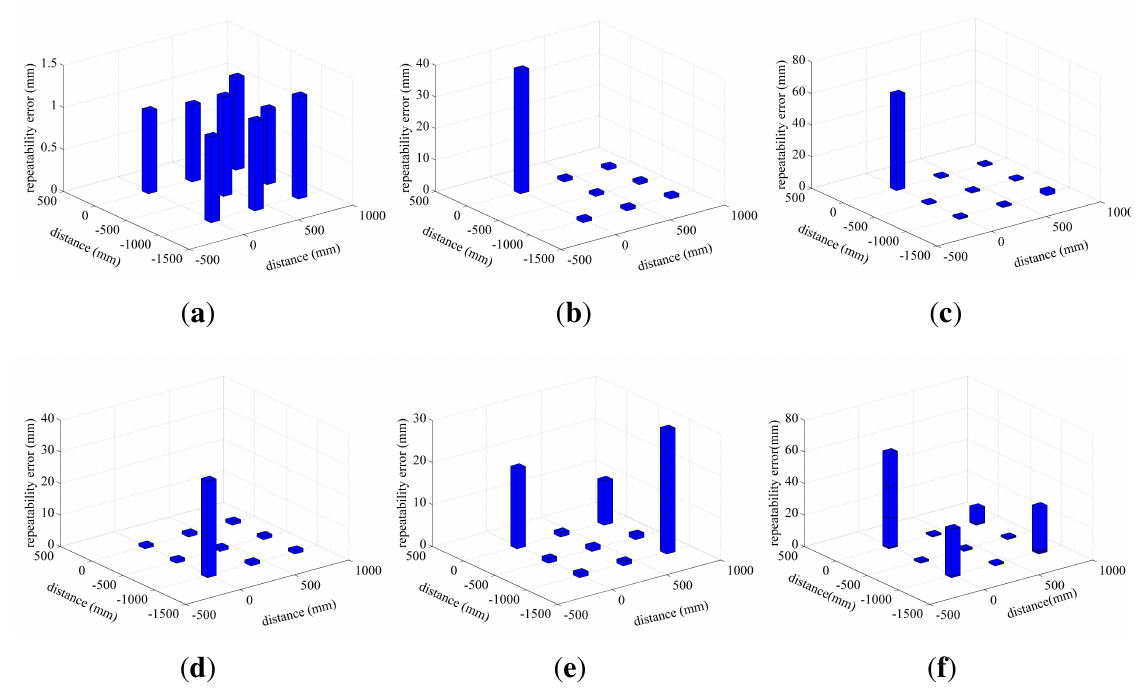
Figure 3. The histograms of the error of five planes and the merged error of all planes. Table 2. The standard deviations of lines (units: